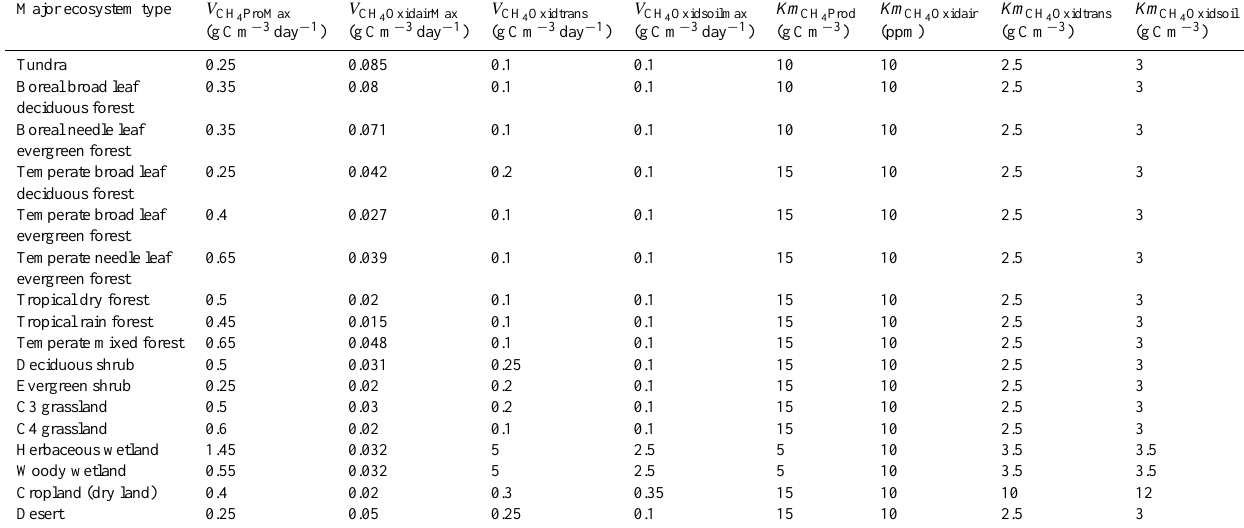
Table 4. Values of the major parameters for different ecosystem types in methane module after the Bayesian calibration. Major ecosystem type